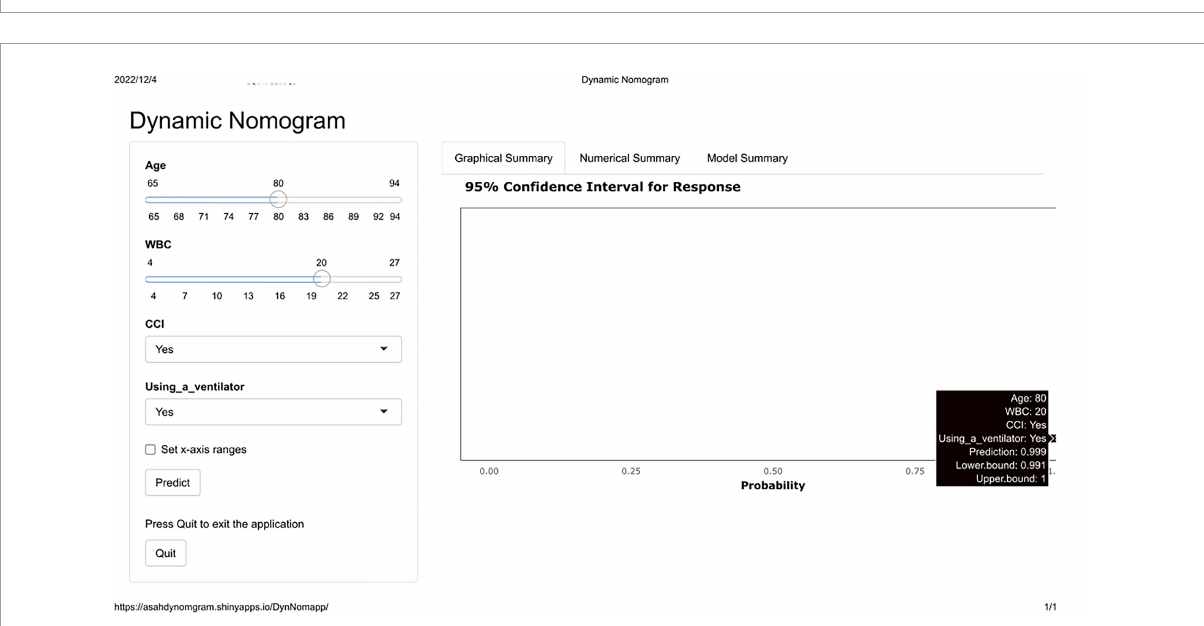
FIGURE2 Dynamic nomogram for predicting 6-month unfavorable outcome in elderly cohort with aneurysmal subarachnoid hemorrhage (aSAH) treated by endovascular coiling. WBC, white blood cell count; CCI, complicated with cerebral infarction.